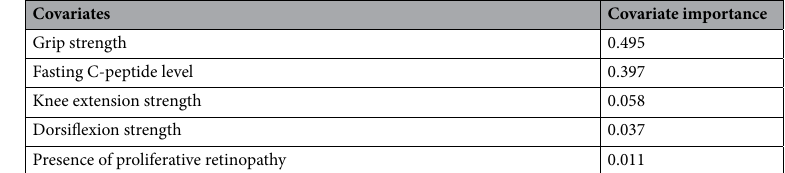
Table 5. Average importance of covariates in the random forest model. Covariates: sex, fasting C-peptide levels, impaired vibratory sensation, presence of proliferative retinopathy, past history of stroke, taking sulfonylureas at discharge, skeletal muscle percentage, body fat percentage, knee extension strength, knee extension endurance, dorsiflexion strength, toe pinch force, grip strength, and index of postural stability.